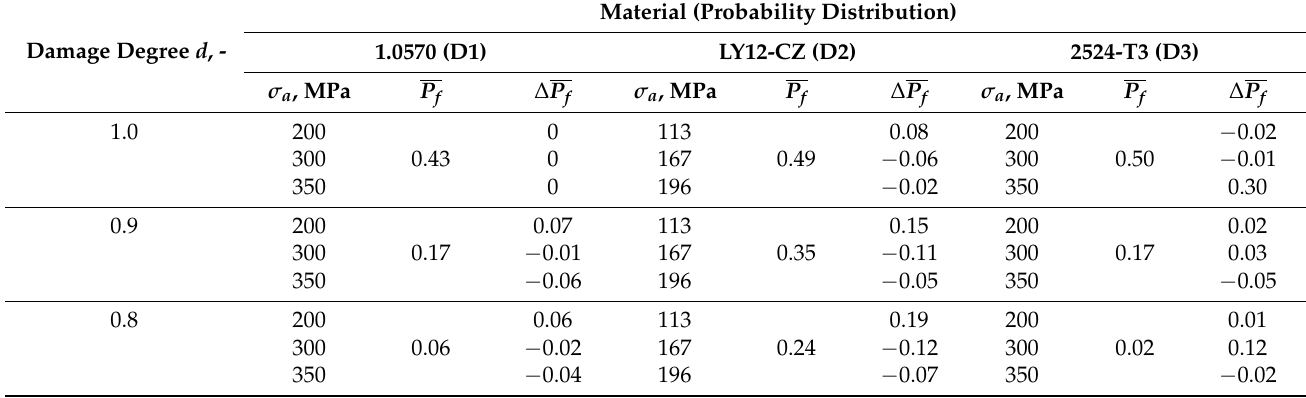
Figure 6. Comparisons between the probability of fatigue failure and damage degree at the different number of load cycles, where ( a) –( c ) 1.0570 steel. Comparisons between the probability of fatigue failure and damage degree at the different number of load cycles, where ( d) –( f ) LY12-CZ aluminium alloy. Comparisons between the probability of fatigue failure and damage degree at the different number of load cycles, where: ( g) –( i ) 2524-T3 aluminium alloy. Table 6. Correlation between the damage degree and probabilities of failure at different stress levels, where P f is the probability of failure (arithmetic mean), ∆ P f is the difference between the mean probability of failure and probabilities at the given stress level, and σ a is the stress amplitude.